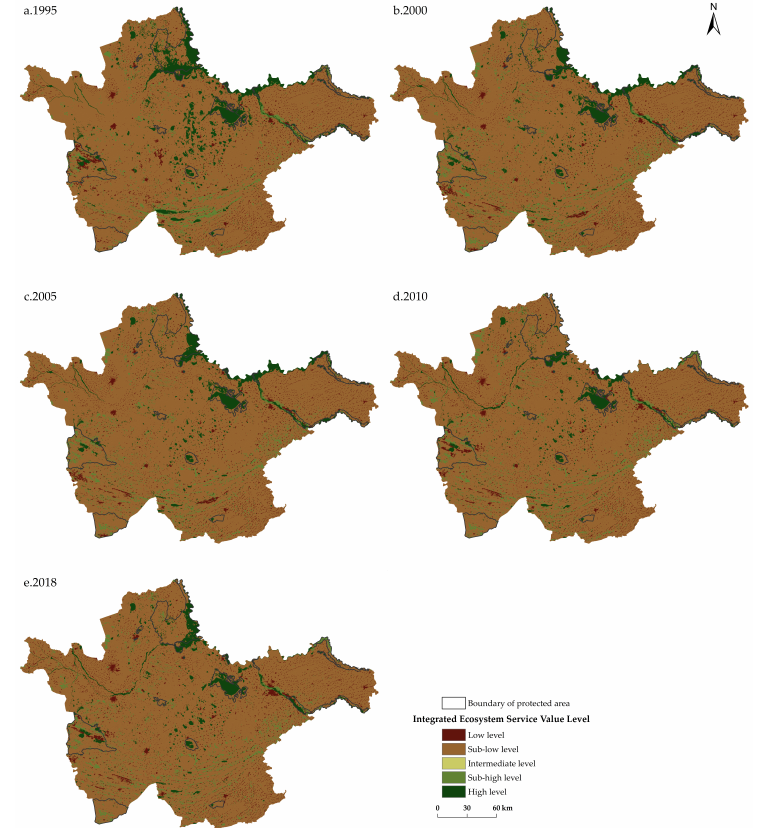
Figure 3. Spatial distribution characteristics of IESV from 1995–2018.